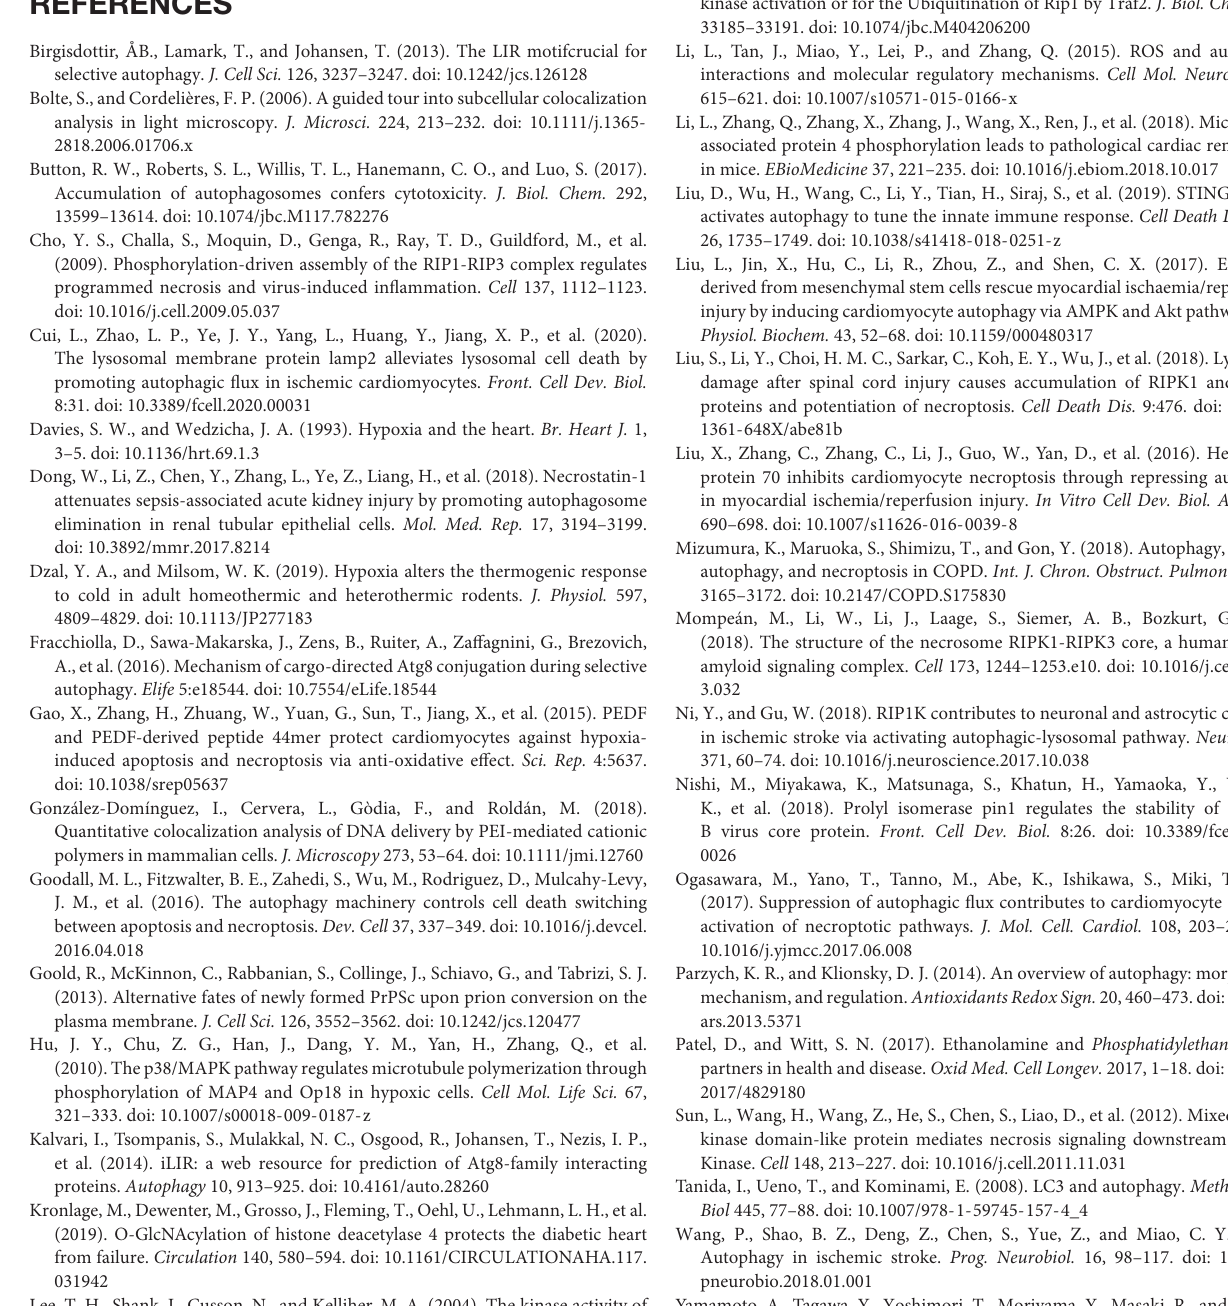
of corresponding groups in panel (G) . Mean ± SEM, n = 5. ∗∗ p < 0.01 versus the Hypoxia + CMV group, ## p < 0.01 versus the Hypoxia + ATG5-KD group. (K,L) Representative confocal images and statistical analysis of p-MLKL in corresponding groups in panel (G) Scale bar, 10 µ m, Mean ± SEM, n = 3. ∗∗∗ Supplementary Figure 6 | (A,B) The PI staining and statistical analysis from Ctrl, Hypoxia, and Hypoxia + Nec-1 groups. Mean ± SEM, n = 3. ∗∗∗ p < 0.001 versus the Ctrl group and ## p < 0.01 versus the Hypoxia